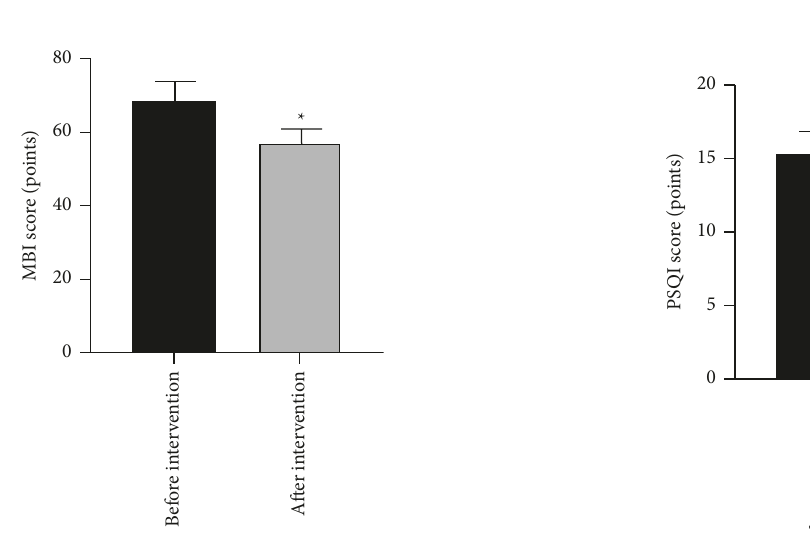
Figure 4: Comparison of job burnout before and after intervention compared with before intervention, ∗ P < 0 . 05. Comparison of sleep quality before and after intervention.